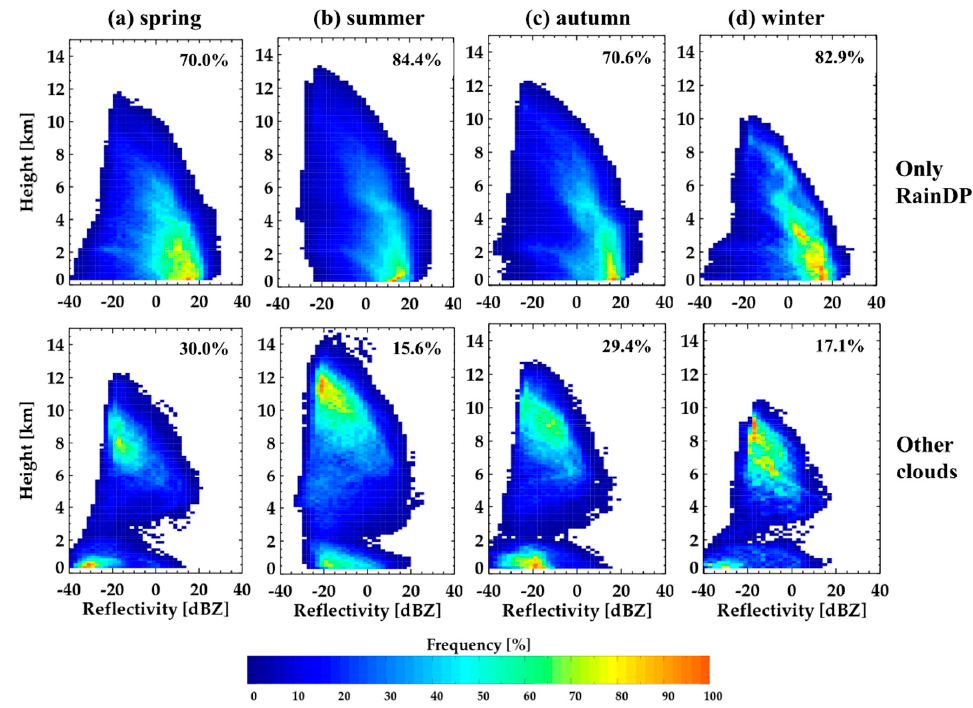
Figure 18. CFADs of reflectivity for (upper) vertically continuous RainDP and (lower) multi-layer RainDP with seasons. ( a ) Spring, ( b ) summer, ( c ) autumn, and ( d ) winter. The RainSH showed different characteristics with the seasons (Figure 19). Common rapid increases in reflectivity (Doppler velocity) were shown in summer, while the other seasons showed constant or decreasing reflectivity (Doppler velocity) due to evaporation. An updraft of larger than 1 m s − 1 occurred at a 1.5 km height in summer. In particular, the reflectivity gradient was about 20 dBZ km − 1 in the layer of 1.5 km (Z = − 20 dBZ) to 0.5 km (Z = 0 dBZ), indicating that the growth of precipitation particles was the most efficient in summer. The updraft appeared in the lower layer in the different seasons and no systematic increases in the Doppler velocity were shown.